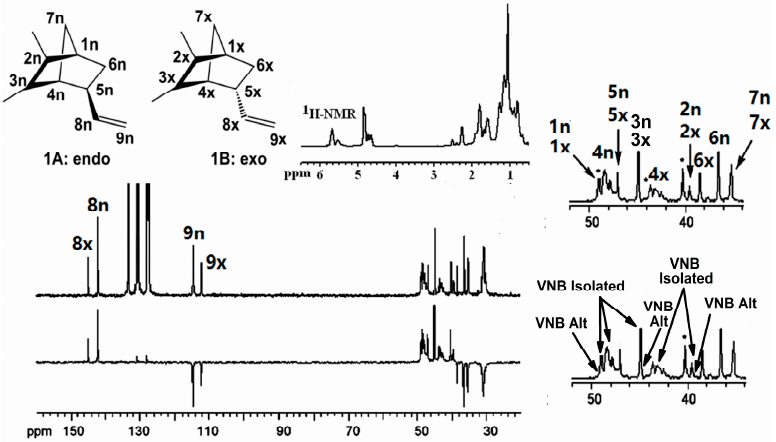
Figure 2. 13 C and 1 H NMR spectra of E/VNB copolymer with VNB incorporation of 33.0 mol % produced by b /Et 2 AlCl/ETA catalytic system (Entry 14 in Table 1).